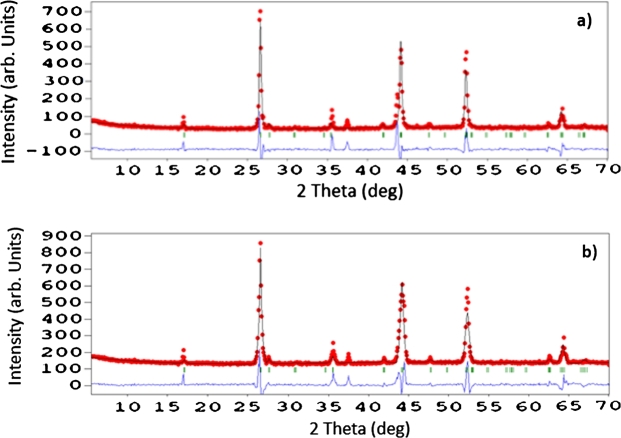
Observed, calculated, and different profiles for the final Rietveld refinement for sample pattern of a) THM and b) VBM crystals.